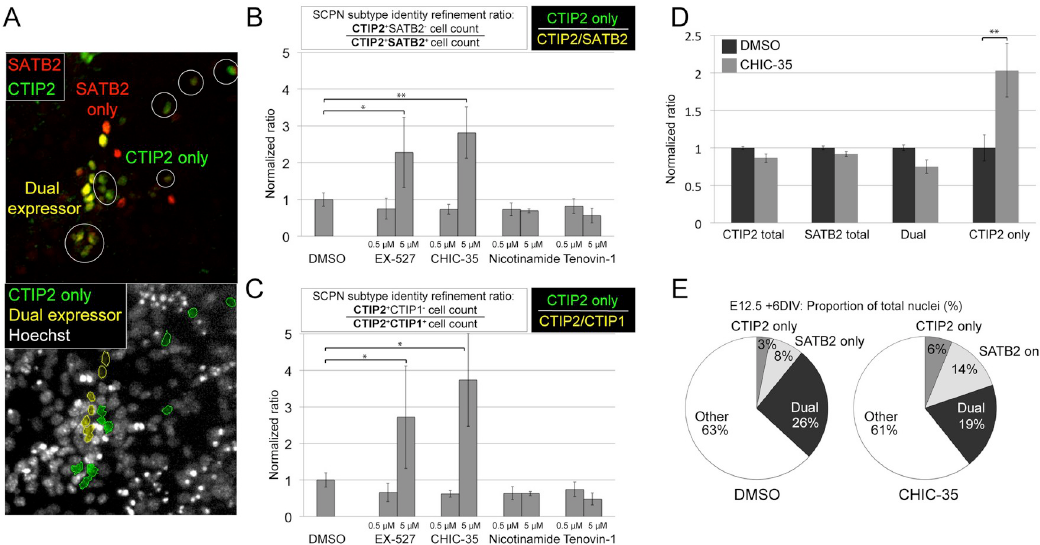
Fig 3. SIRT1 inhibition in dissociated E12.5 neocortical neurons enhanced SCPN/CSN subtype refinement, increasing the number of CTIP2-expressing, SATB2-negative neurons at the expense of CTIP2/SATB2 dual-expressing neurons. (A) Representative image of E12.5 primary dissociated neocortical cells following six days of culture and representative immunostaining with CTIP2 and SATB2. CTIP2+/SATB2- neurons (pseudo-colored green) could be distinguished from CTIP2+/SATB2+ “dual expressor” neurons (pseudo-colored yellow) and counted using our automated imaging and cellular segmentation protocol (S3C– S3E Fig). (B) EX-527 and a more specific SIRT1 inhibitor, CHIC-35, increased CTIP2 + /SATB2 - subtype distinction relative to DMSO-only controls (0.5 micromolar and 5 micromolar). (C) EX-527 and CHIC-35 also trended toward CTIP2 + /CTIP1 - subtype distinction. (D) Importantly, while the proportions of total CTIP2- and total SATB2-expressing neurons did not change relative to DMSO control following CHIC-35 SIRT1 inhibition, the relative proportion of CTIP2/SATB2 dual-expressing neurons decreased. In contrast, the relative proportion of more fully distinguished CTIP2(+)/SATB2(-) neurons increased (reflecting improved SCPN/ CSN differentiation). (E) Pie chart schematics show the relative proportions of total nuclei of CTIP2+-only neurons, SATB2+-only neurons, CTIP2+/SATB2+ dual expressing neurons, and unlabeled cells derived from E12.5 neocortical cells in CHIC-35 SIRT1 inhibition treatment conditions versus DMSO control. Data are presented as mean +/- s.e.m. (N = 3; > 5,000 nuclei screened per condition from 40 randomly sampled fields at 20x magnification) � P < 0.05; �� P < 0.01 (unpaired